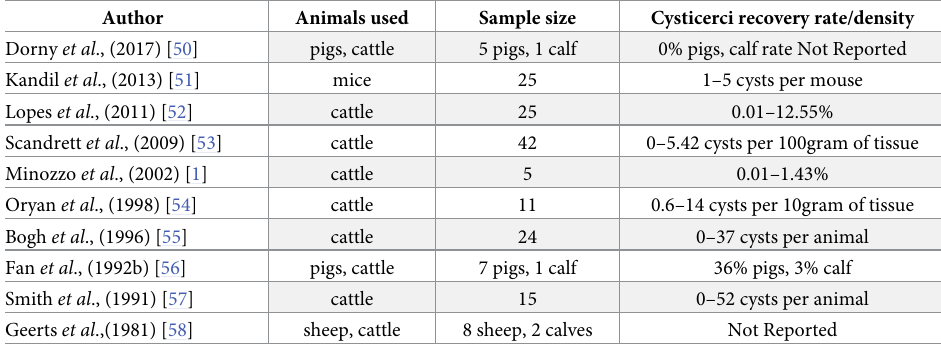
Table 2. Description of the animal models used in the included studies for T . saginata .